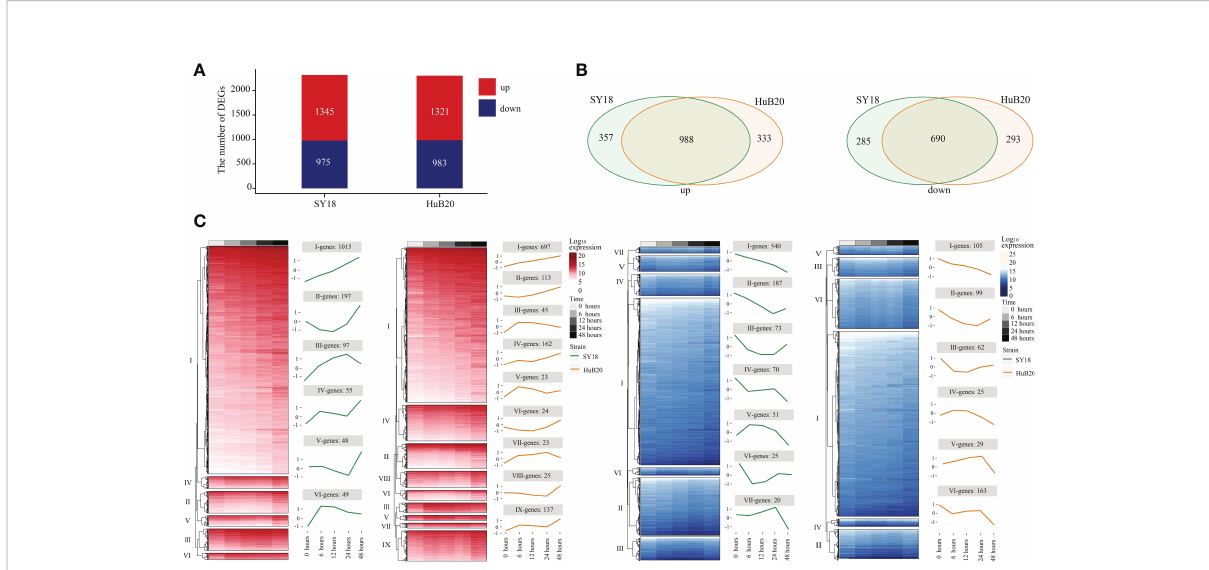
FIGURE 3 Differentially expressed genes (DEGs) analysis in host with time series. DEGs are examined by the Likelihood Ratio Test (LRT) to explore the genes with signi fi cantly differential expression levels across a series of time points (P-value (P) < 10 -10 ). (A) The stacked plot shows the number of upregulated (red) and downregulated (blue) DEGs of PAMs after being infected by SY18 (left) and HuB20 (right) strains, respectively. (B) The Venn diagrams show the shared genes in the two strains for upregulated (left) and downregulated (right) DEGs. (C) The heatmap of the DEGs with hierarchical clustering shows the expression levels of upregulated (red) and downregulated (blue) DEGs of PAMs infected by SY18 and HuB20 strains separately. The line plots illustrate the average trend of gene expression in hierarchical